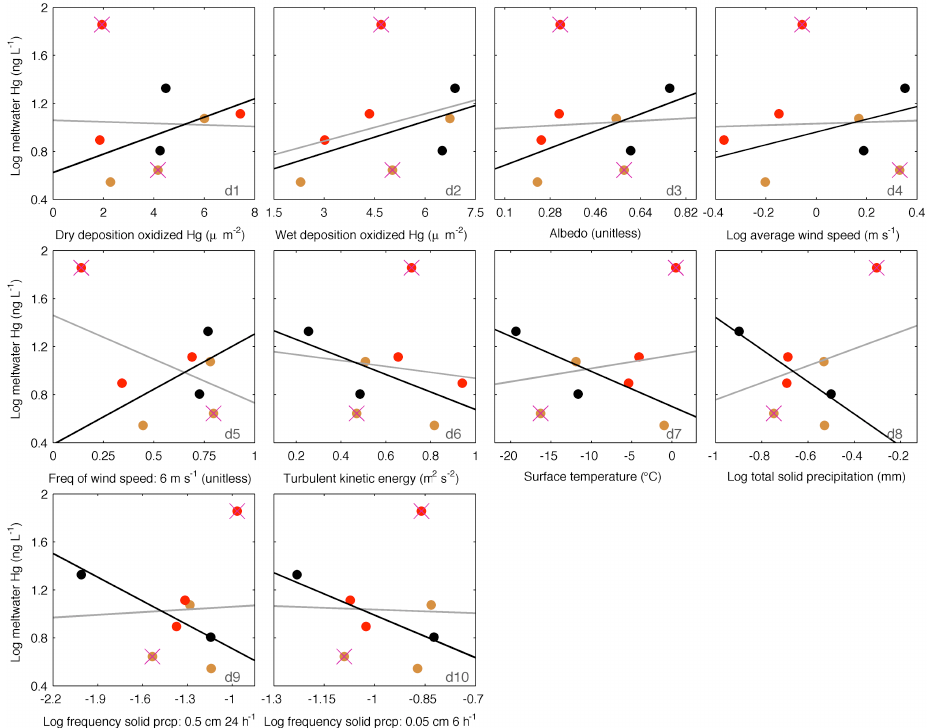
Fig. 6. Scatter plots of sufficiently strongly and significantly correlated model environmental variables with Set2’s concentration of mercury in the snowpack meltwater’s ionic pulse. Plotted as per Fig. 4.